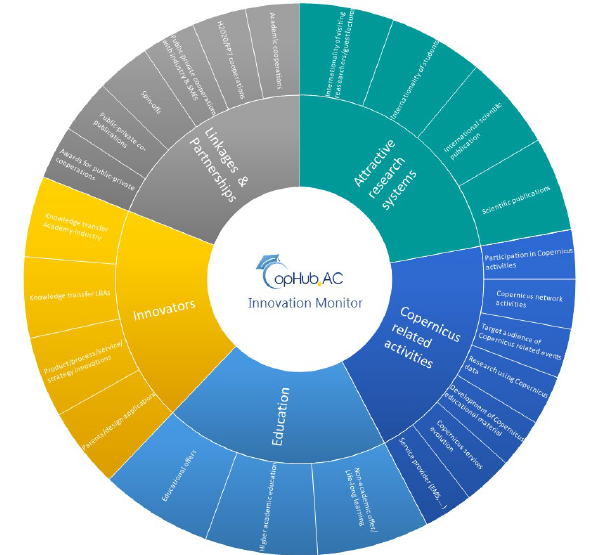
Figure 5. Innovation monitor - dimensions and